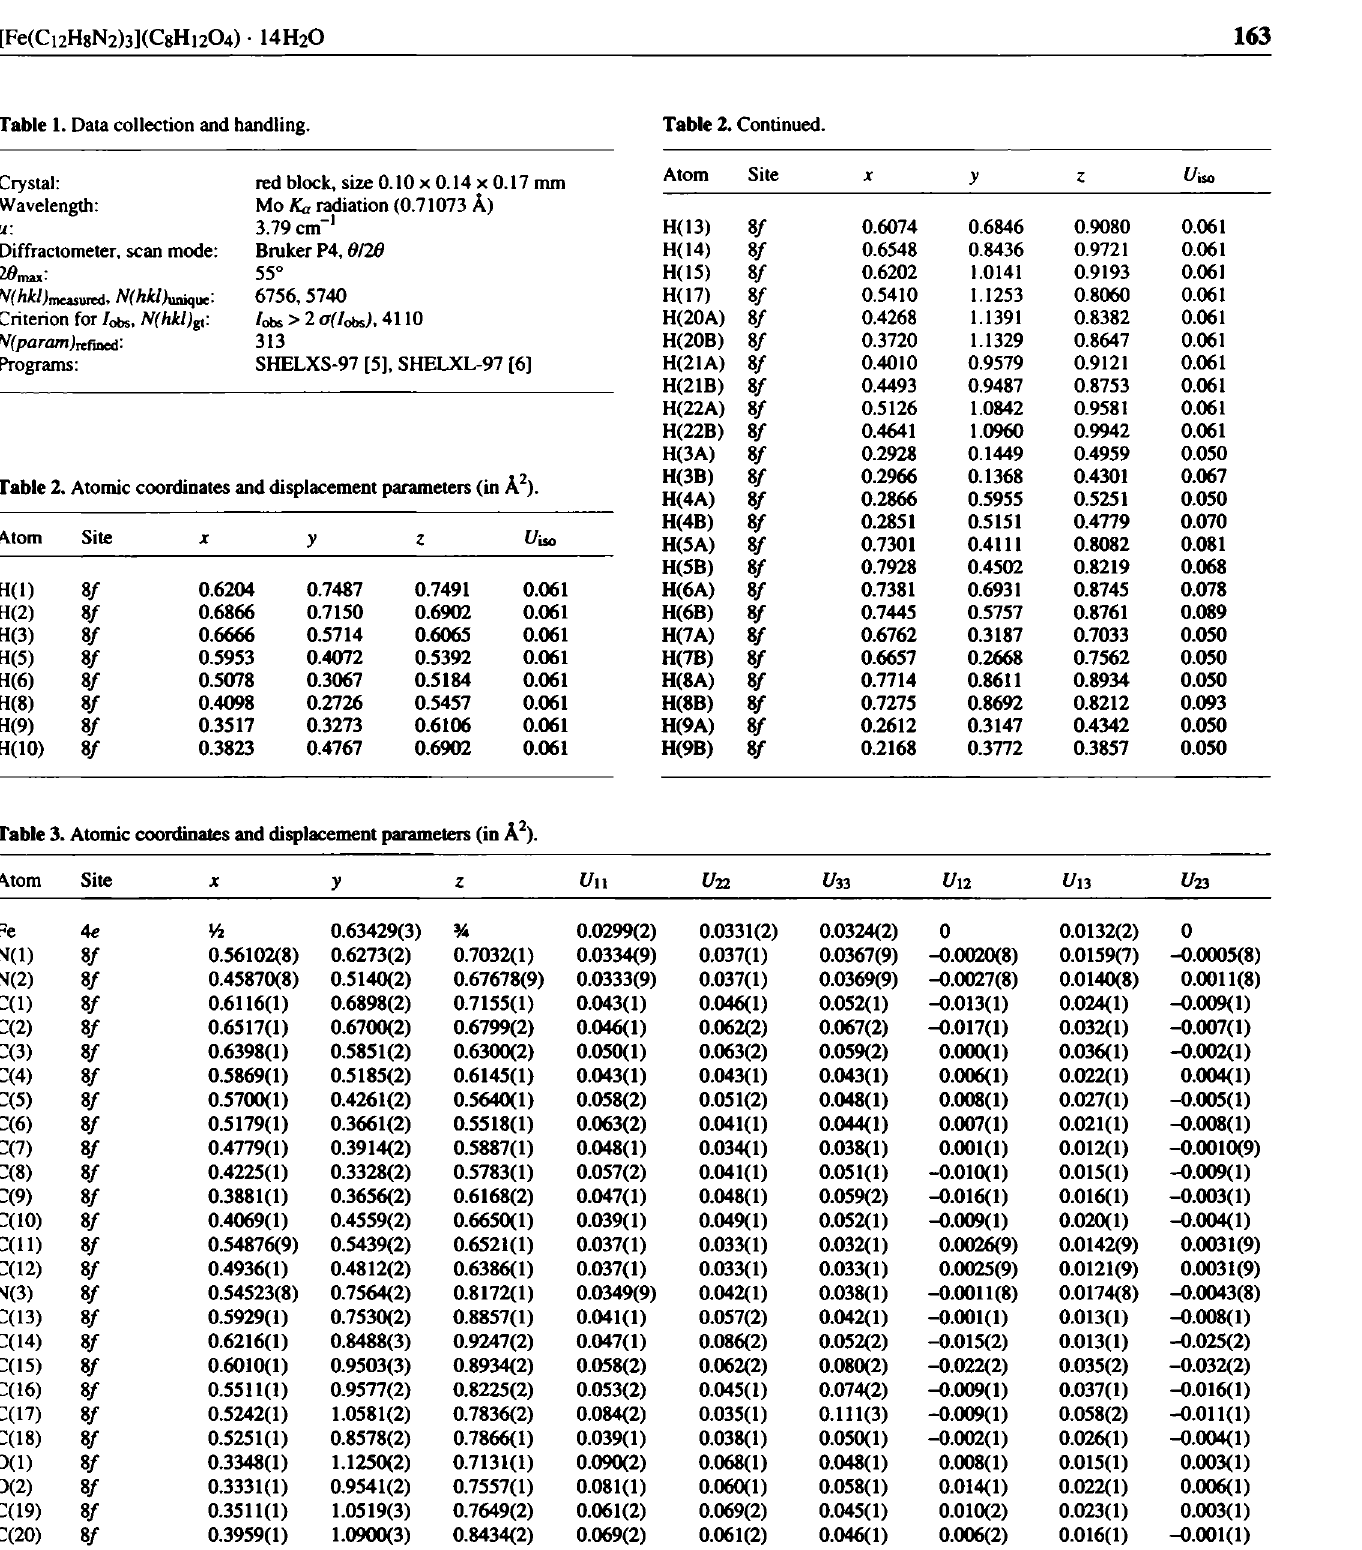
Table 1. Data collection and handling.